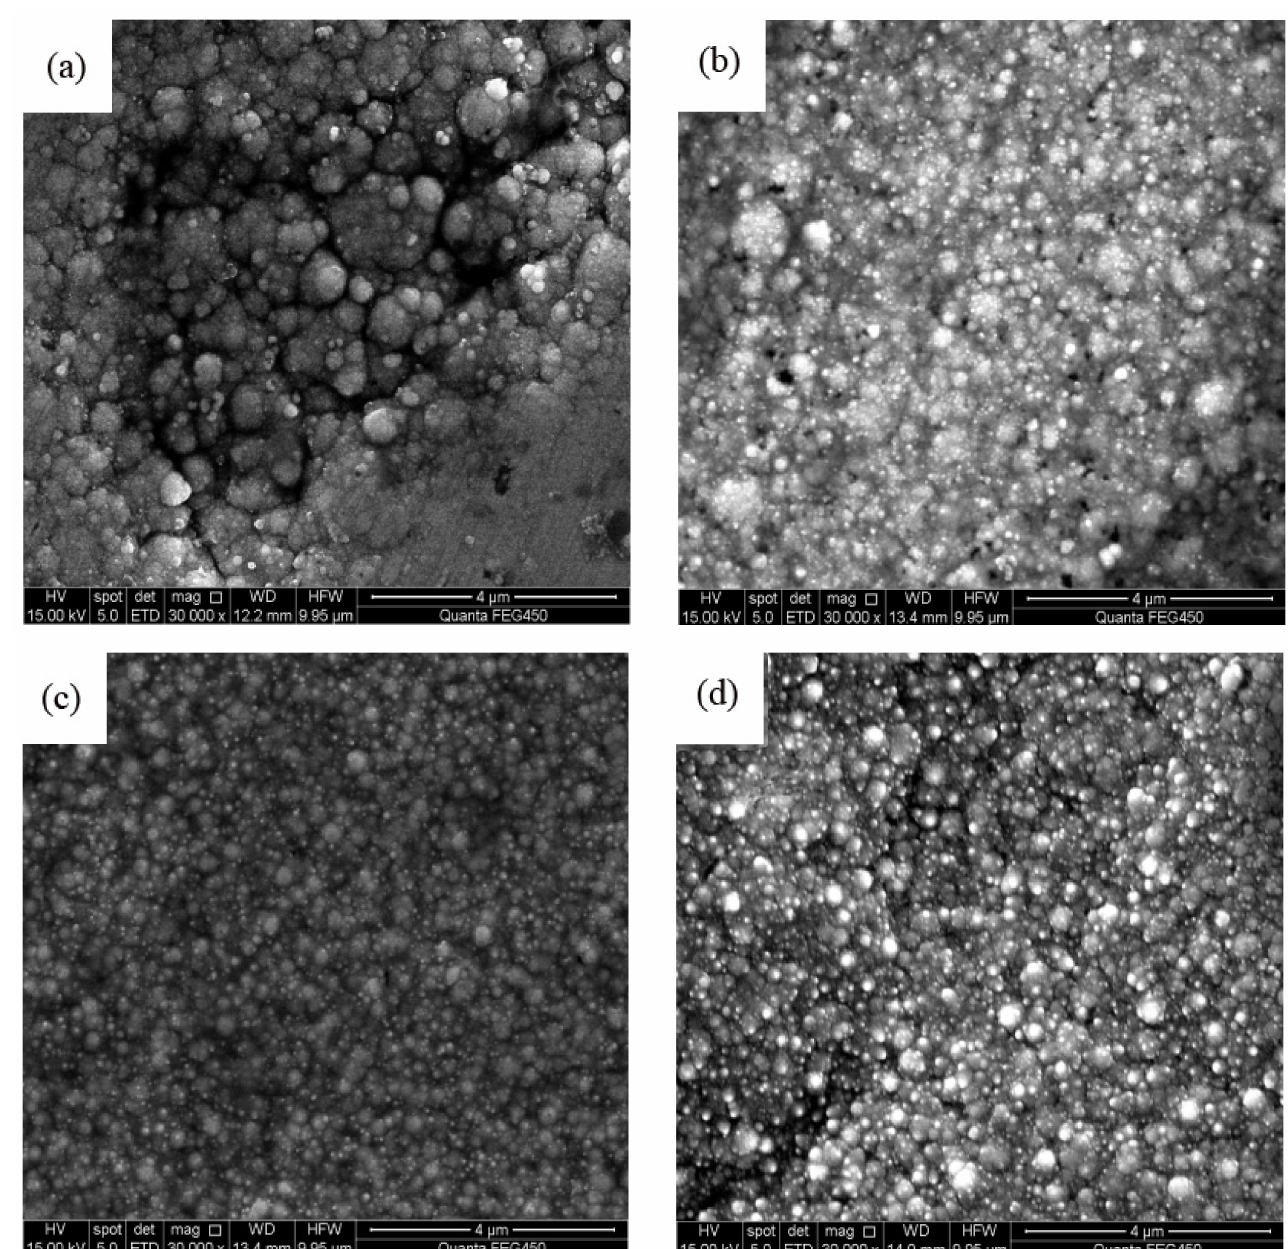
Figure 4. SEM graphs of Ni–TiN coatings deposited at diverse nozzle diameters: ( a ) Nf = Φ 3 mm, ( b ) Nf = Φ 5 mm, ( c ) Nf = Φ 7 mm, ( d ) Nf = Φ 9